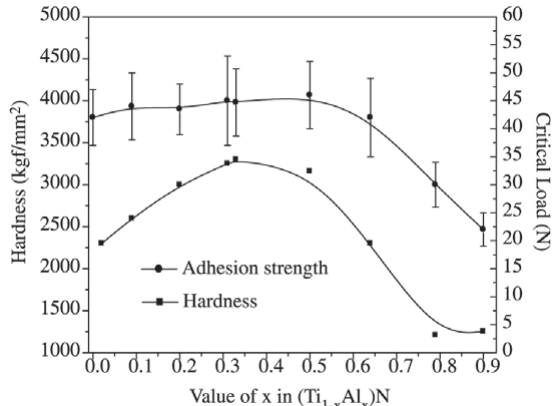
Figure 2. Hardness and adhesion strength of coatings (Ti, Al)N vs. Al